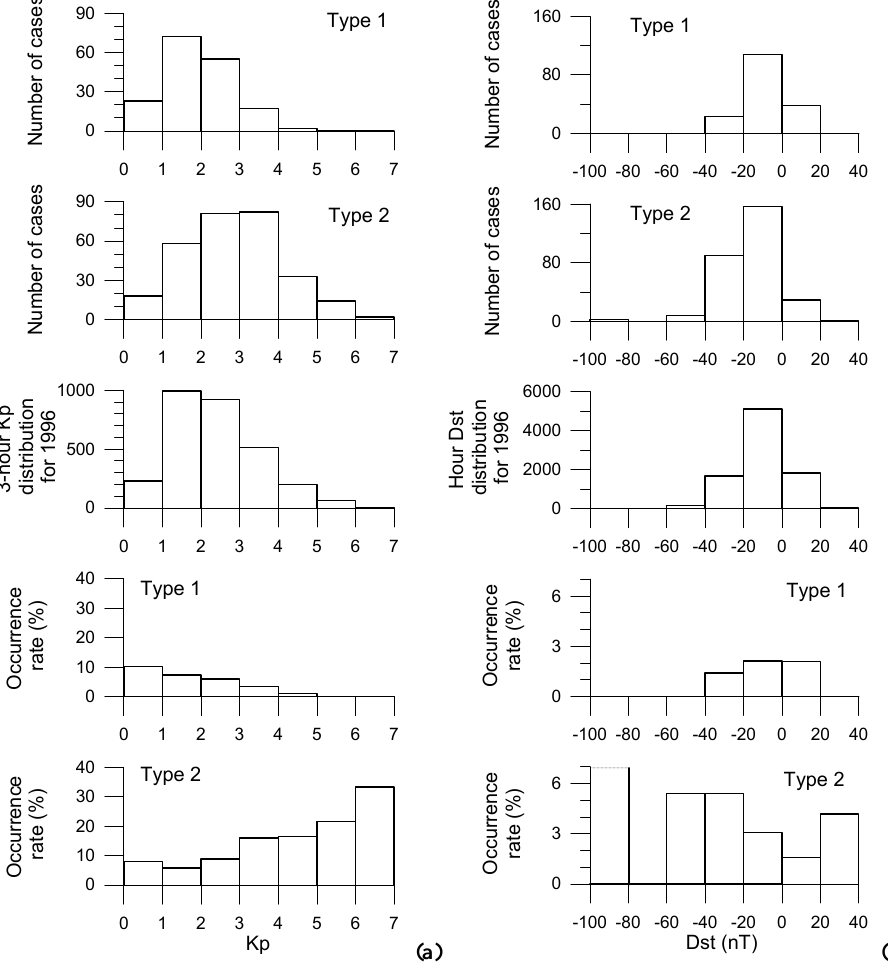
Fig. 4. Occurrence rate of localized proton precipitations as a function of geomagnetic activity indices K p (a) and D st (b) . From top to bottom: number of the Type 1 and 2 events as a function of the geomagnetic activity index, distribution of the index for 1996, occurrence rate of the Type 1 and 2 event observations as a function of the